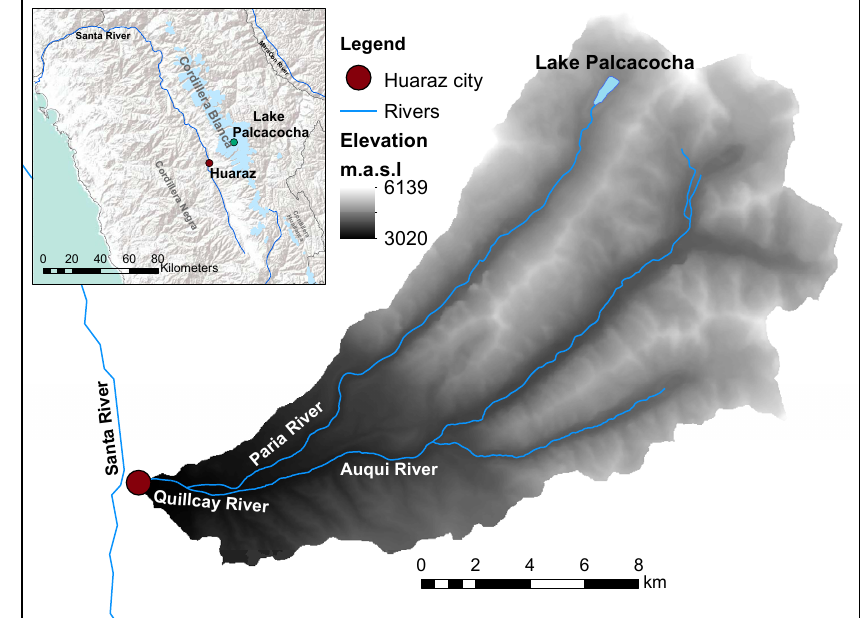
Figure 1. Location of Lake Palcacocha within the Cordillera Blanca,